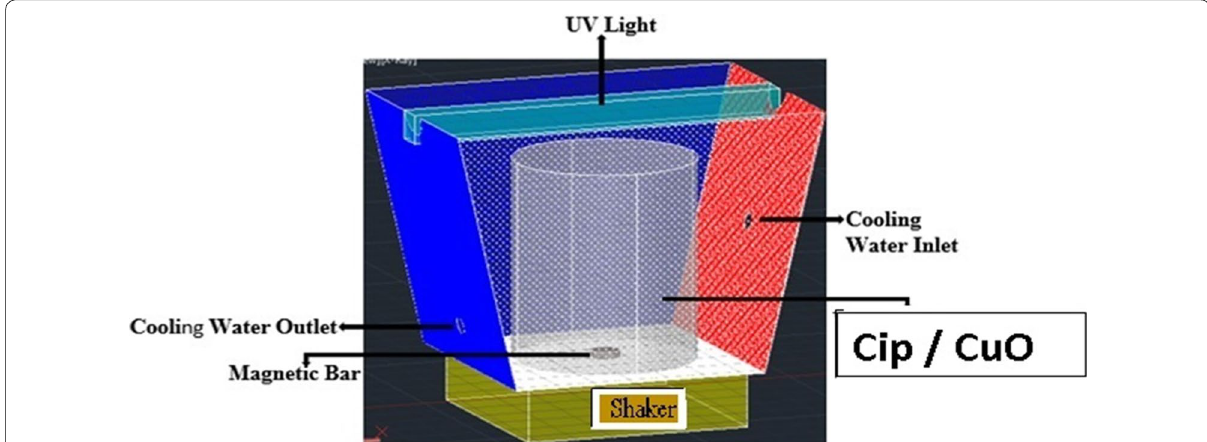
Fig. 3 Schematic diagram of photocatalytic